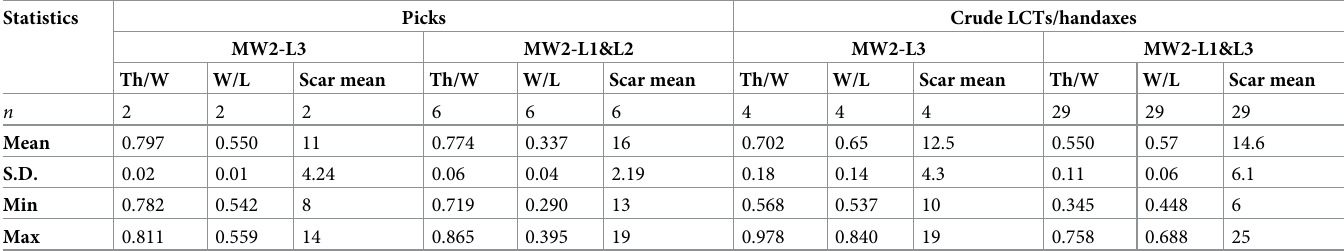
Table 10. Descriptive statistics of the relative thickness, elongation, and total scar frequency of picks and handaxes from MW2 assemblages. Statistics Picks